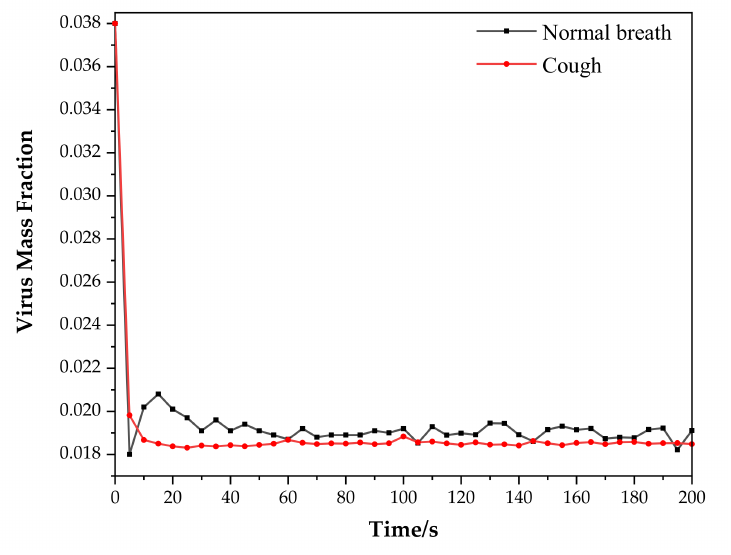
Figure 4. Virus mass fraction at the virus carrier’s breathing zone after a single breath or